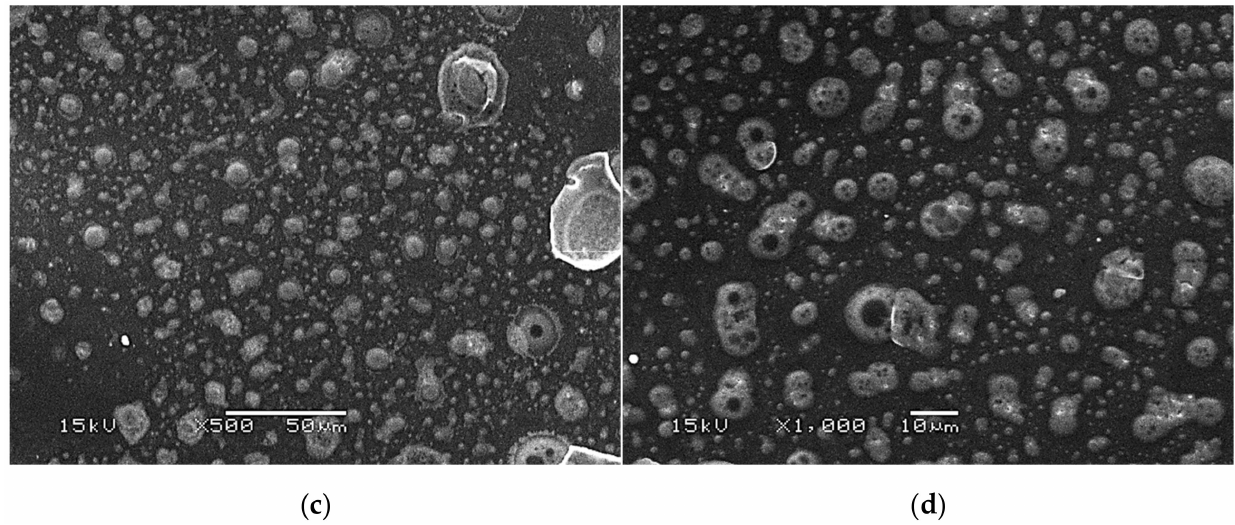
Figure 9. SEM images of modified hydrogels at various magnifications: sample 2.5/8.0 ( × 500) ( a ); sample 2.5/8.0 ( × 1000) ( b ); sample 5.0/8.0 ( × 500) ( c ); sample 5.0/8.0 ( × 1000) ( d